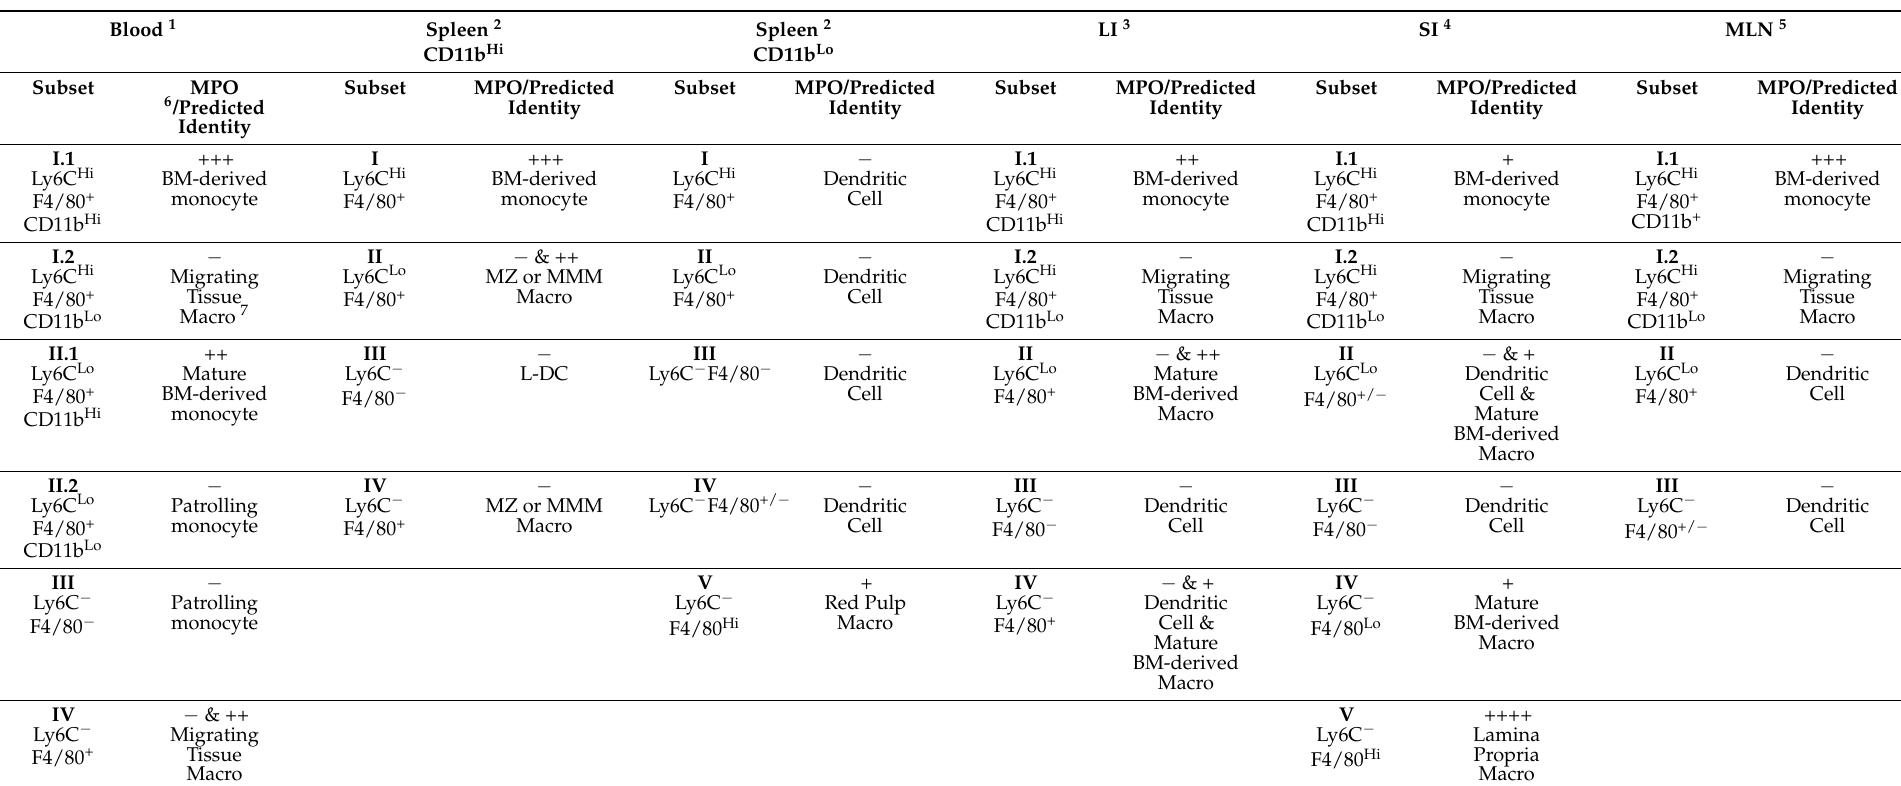
Table 1. MPO Expression Level in Monocyte/macrophage Subsets Differentiated by Ly6C, F4/80 and CD11b Cell Surface